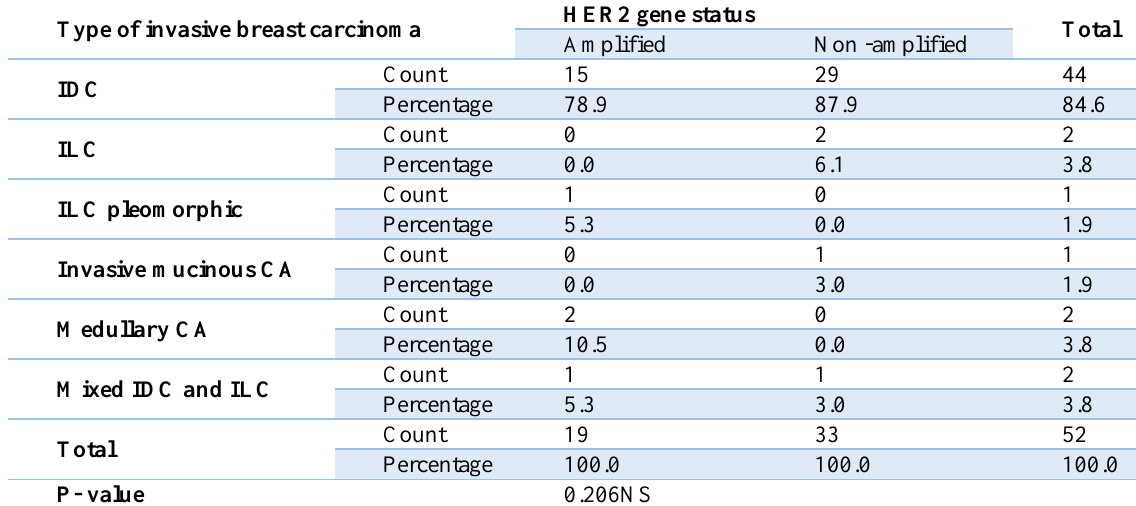
Table. 5. Association of HER2 Gene Status by Silver DNA in Situ Hybridization with Types of Invasive Breast Carcinoma Type of invasive breast carcinoma